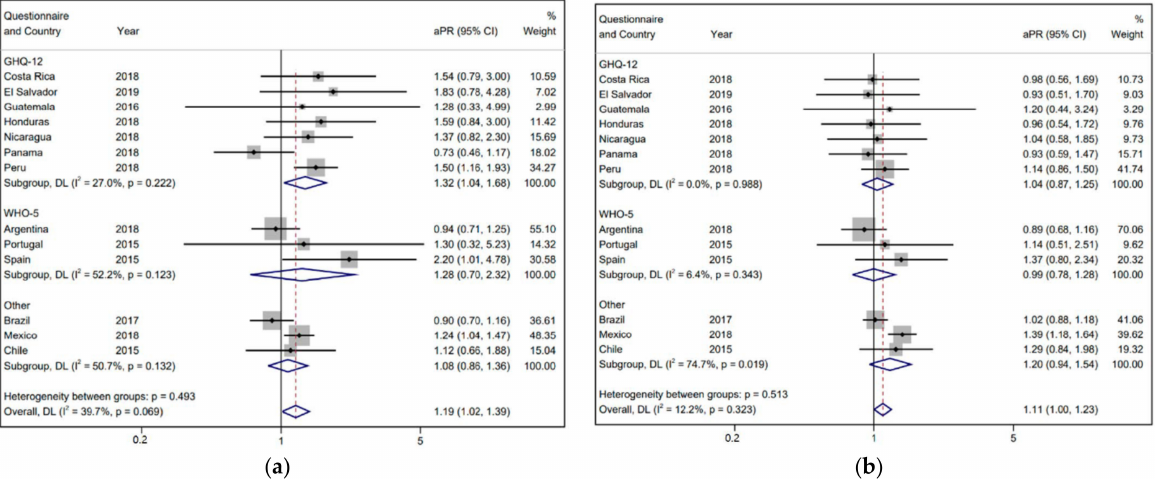
Figure 1. Forest plots showing adjusted prevalence ratios (aPR) of poor mental health between informal and formal workers of Iberoamerica, by country and mental health questionnaire, and overall estimates from the meta-analysis. ( a ) Men. ( b ) Women. The dashed red line shows the overall